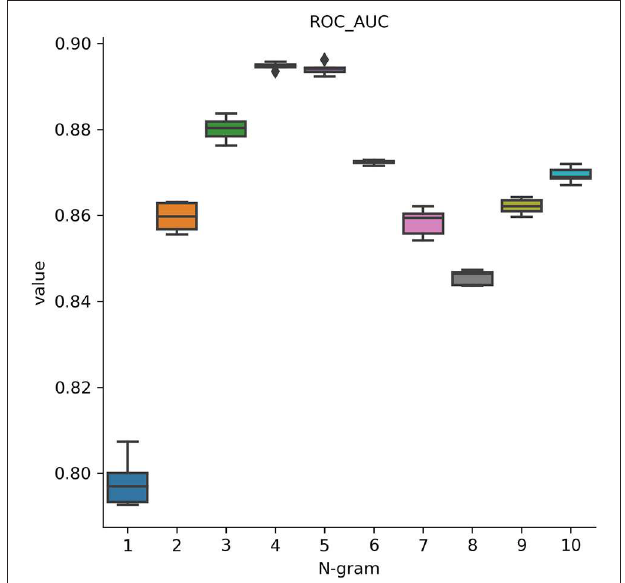
FIGURE 3 | Performance results on identifying promoters using different levels of N-gram. Our classifier could classify promoters with high performance (AUC 0.9), especially at 4-gram and 5-gram levels. ∼